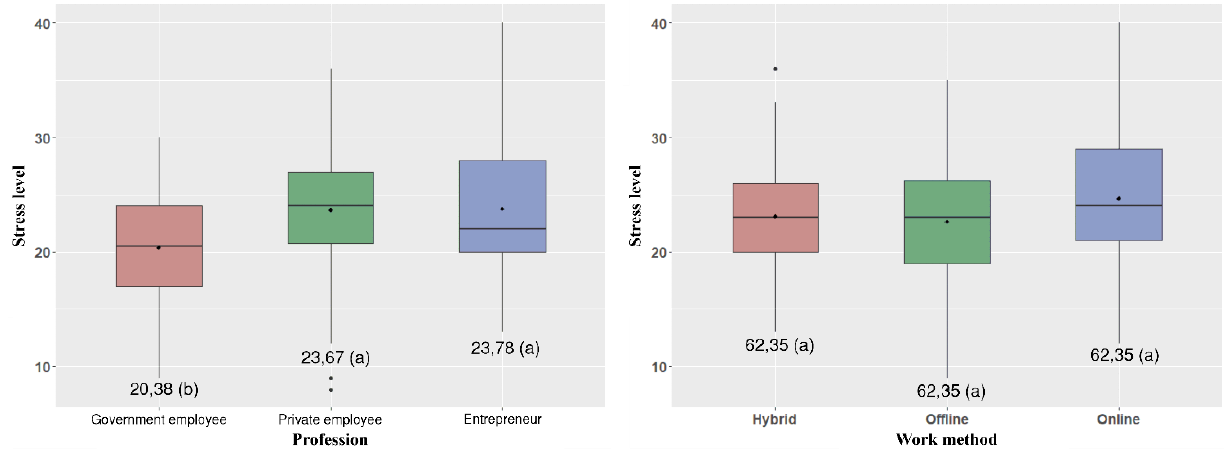
Figure 6 . Box plot of profession factor with stress level (left) and work method factor with stress level